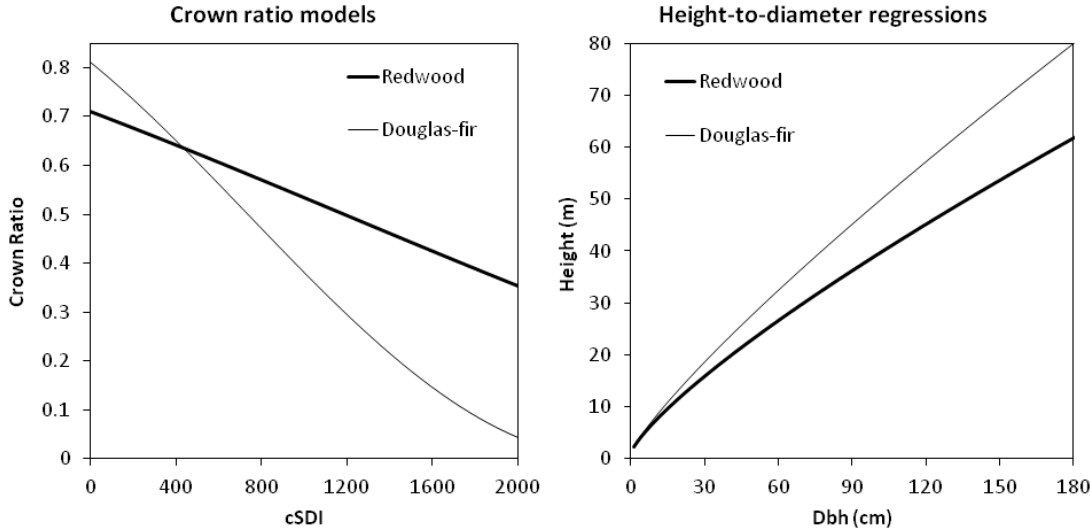
Figure 4. Relationships between crown ratio and competitive SDI (cSDI) for redwood: CR = sin(1.002 − 0.0001823cSDI) 2 ; and Douglas-fir: CR rw (left panel); and height-dbh relationship for redwood: HT = 1.37 + e (0.7899lnDBH); and Douglas-fir: HT = 1.37 + e (0.8407lnDBH) (right panel); for n = 330 trees sampled for growth at Headwaters Forest Reserve,